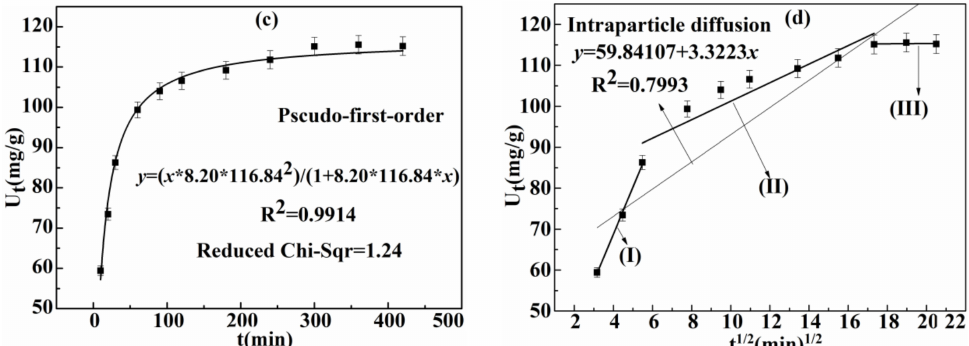
Figure 5. Effect of adsorption time on adsorption of Ag(I) by BA-PGMA ( a ) and kinetic model (pseudo-level ( b ), pseudo-secondary ( c ), intra-particle diffusion ( d